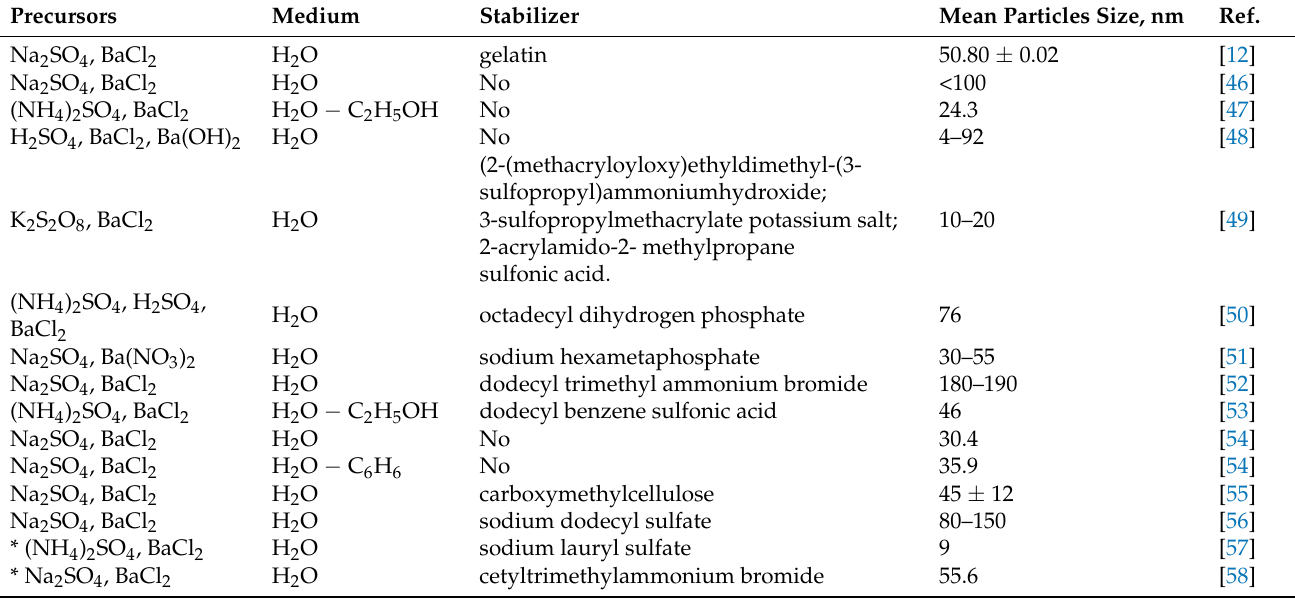
Table 1. Conditions for obtaining barium sulfate nanoparticles by direct precipitation, described in the